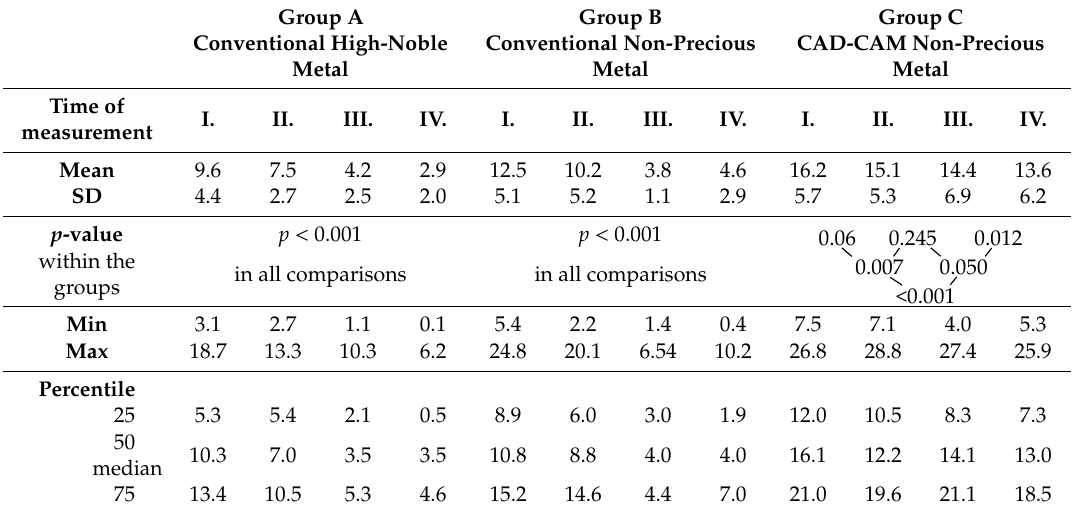
Table 2. Mean, standard deviation (SD), minimum (min), maximum (max) and percentile with median retention force values in groups A to C.